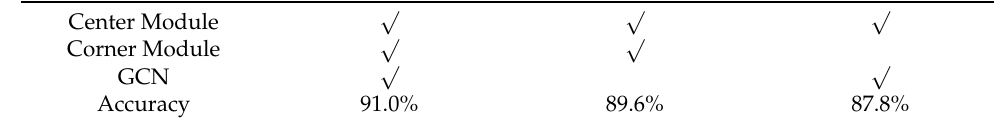
Table 6. Classification results of ablation experiments on